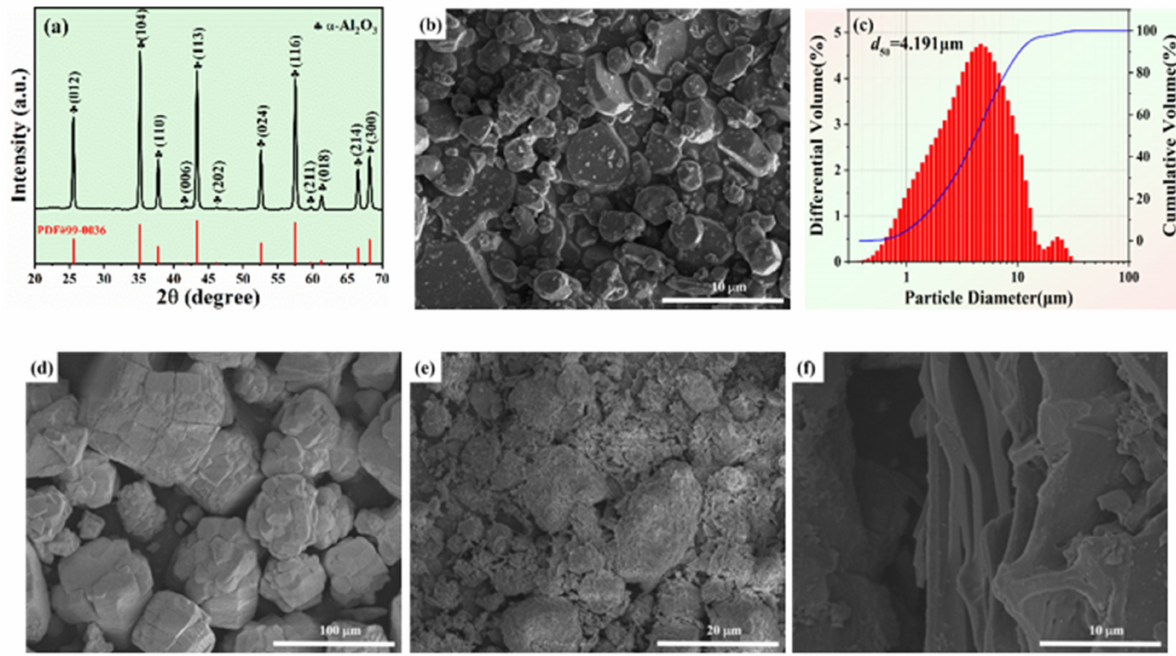
Figure 3. ( a ) The XRD patterns; ( b ) the SEM micrograph; ( c ) the particle diameter of Al 2 O 3 powders with grit designation of 1500#; ( d – f ) the SEM micrograph of raw particles: ( d ) Al 2 O 3 powders with grit designation of 80–150#, ( e ) kaolin particles, and ( f ) carbon powders.